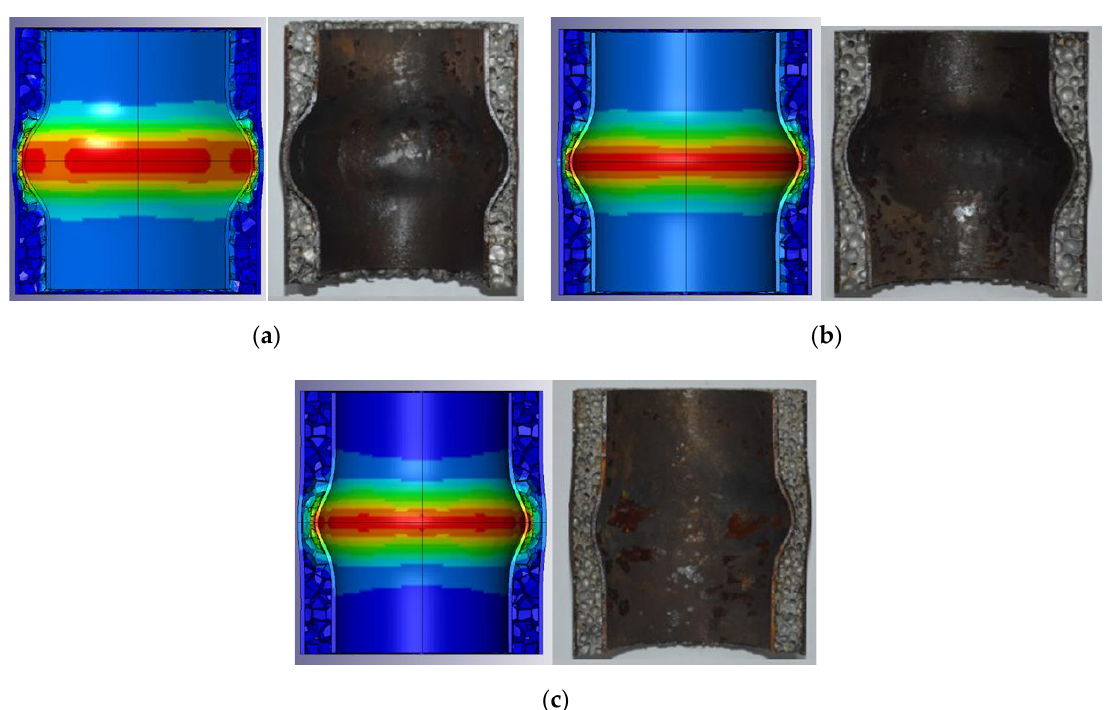
Figure 8. Comparison of numerical simulation and experimental results. ( a ) T1, ( b ) T2, and ( c ) T3.